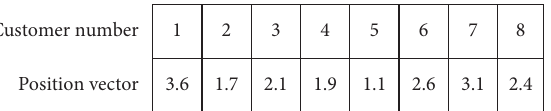
Figure 2: Coding scheme of the hybrid algorithm.